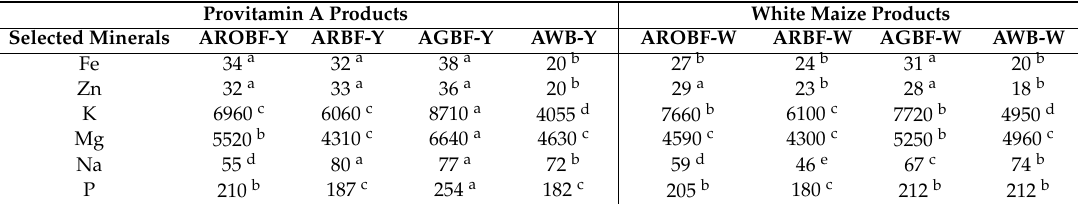
Table 3. Mineral composition of amahewu samples (mg / kg,